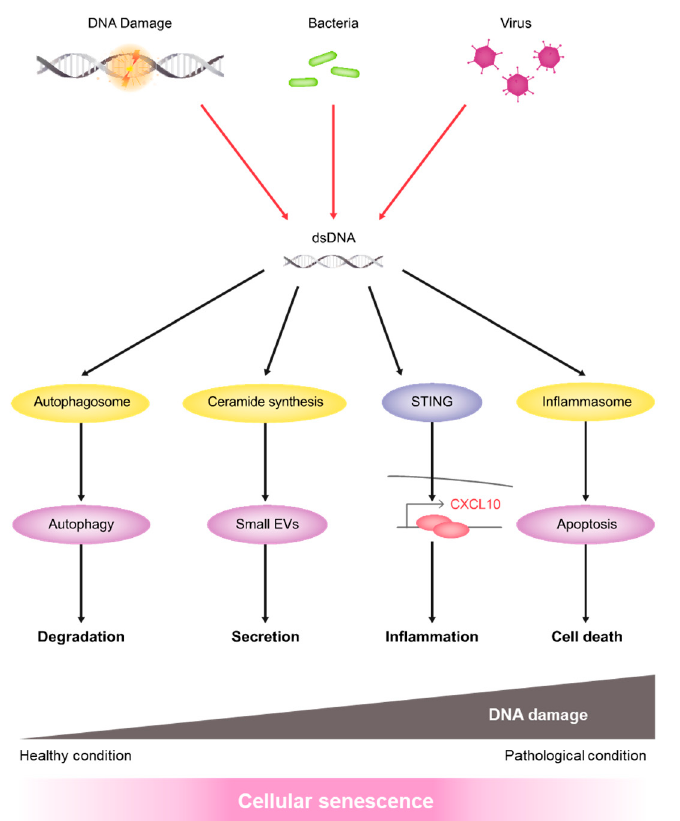
Figure 6. A model of our research. In healthy conditions, endogenous dsDNA fragments, derived from chromosomal or mitochondrial DNA, or exogenous dsDNA fragments, derived from bacterial or viral infection, are degraded by autophagy or released via small EVs. Therefore, these pathways function as defence mechanisms to prevent aberrant activation of innate immune responses. In senescent cells, irreparable DNA damage inhibits dsDNA degradation by autophagy and upregulates small EV secretion by activating the ceramide pathway. If neither pathway can function sufficiently, inflammasome activation occurs, leading to apoptosis. In summary, autophagy and the small EV pathway cooperatively play key roles to support cellular homeostasis.